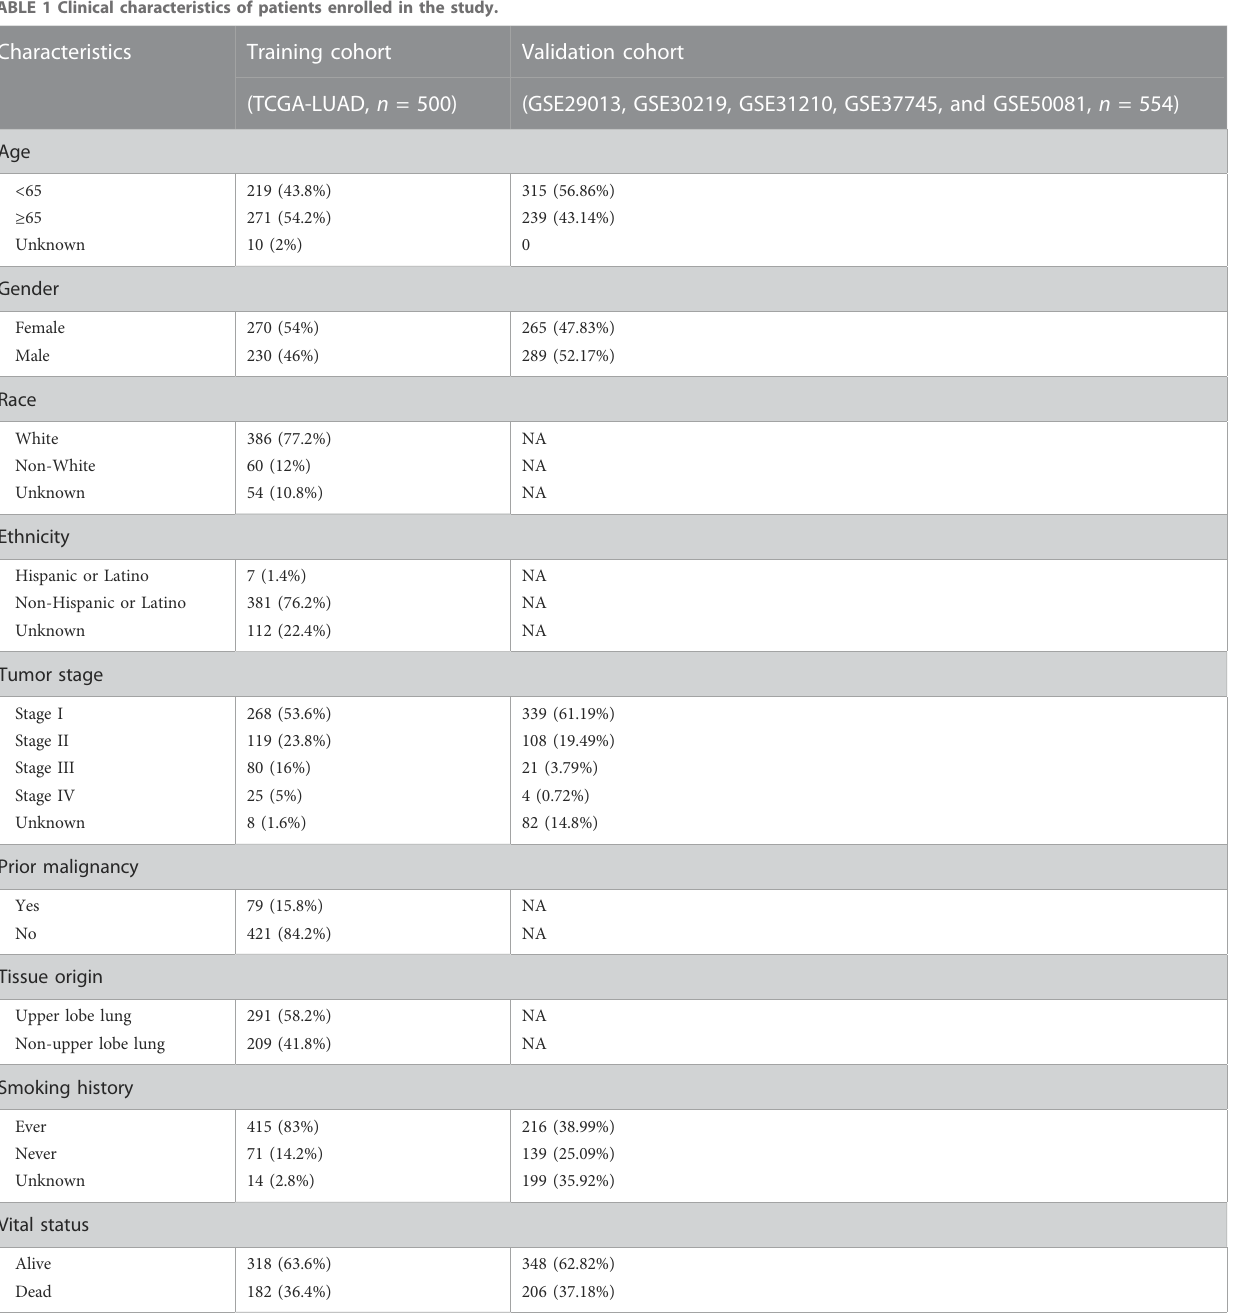
FIGURE 2 (Continued) CRG: cuproptosis-regulated gene; UMAP: Uniform Manifold Approximation and Projection; KM: Kaplan – Meier estimator; DEGs: